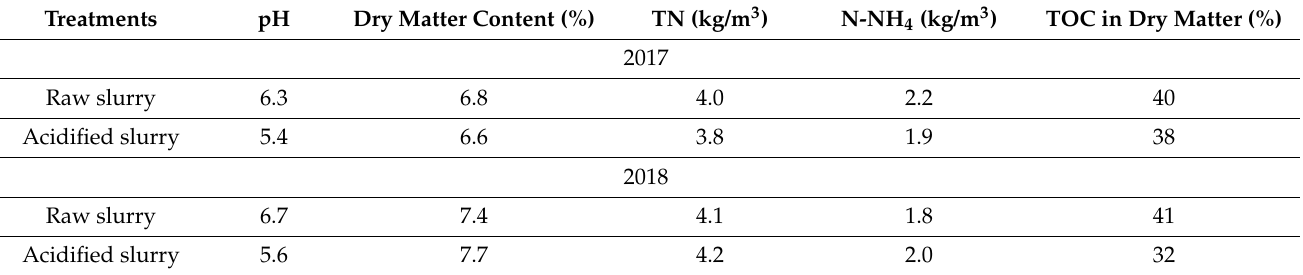
Table 1. Chemical properties of raw slurry and acidified slurry. Treatments